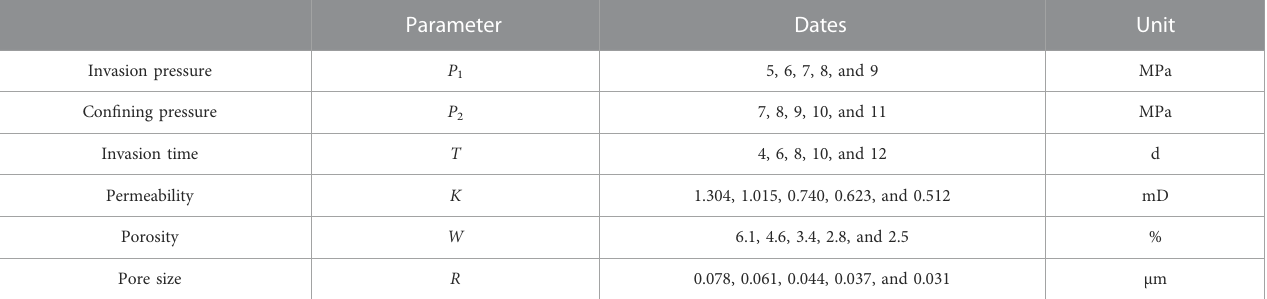
TABLE 2 Parameters.